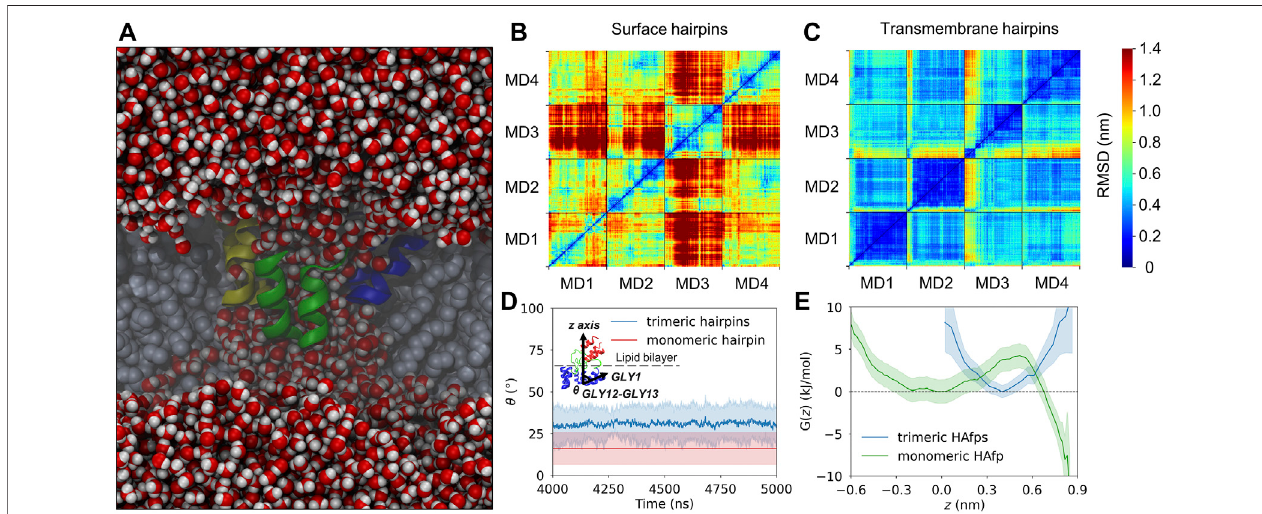
FIGURE 6 | (A) A cross-section of the system along the z -axis showing a sample trimeric transmembrane HAfps (color ribbons) arrangement within POPC membrane (grey spheres) and a central channel of water molecules (red/white spheres). (B,C) Two-dimensional root mean square deviation (2D cross-RMSD) for C α